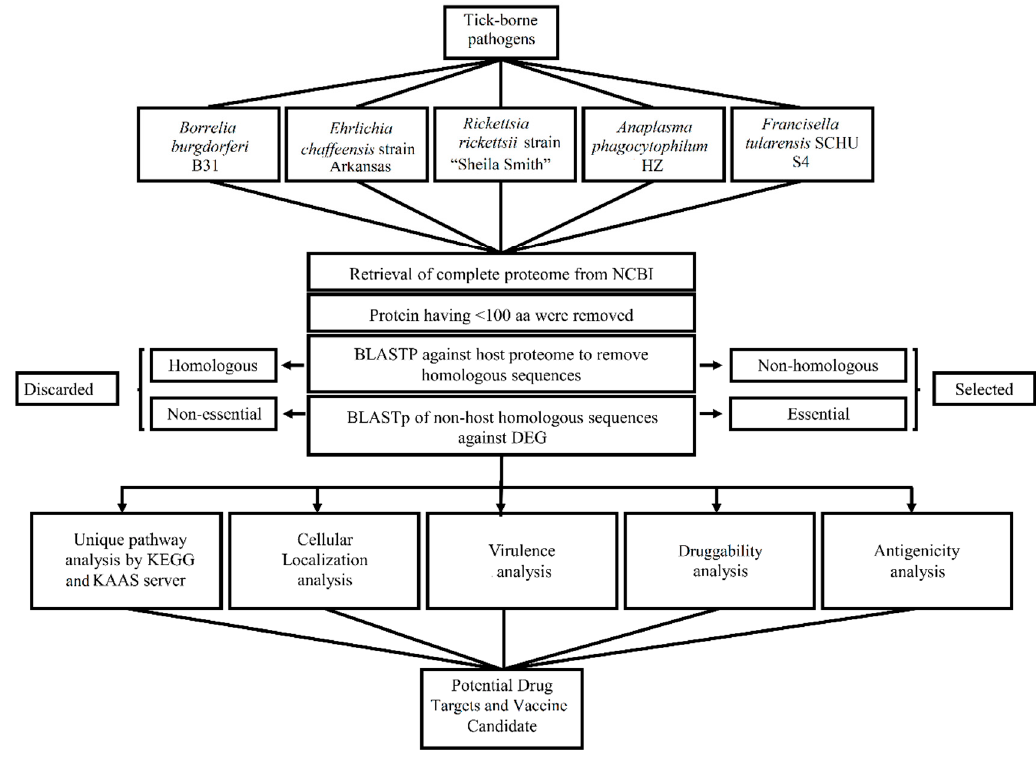
Figure 1. Outline of subtractive proteome analysis of Tick-borne pathogens.